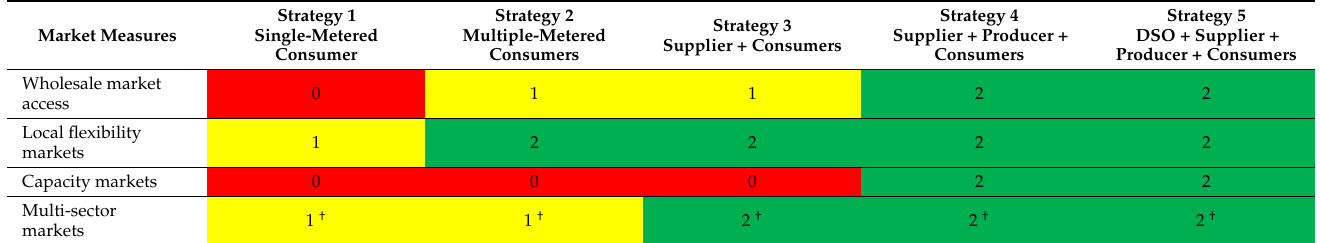
Table 2. Summary of the qualitative impact of market measures on EC organizational